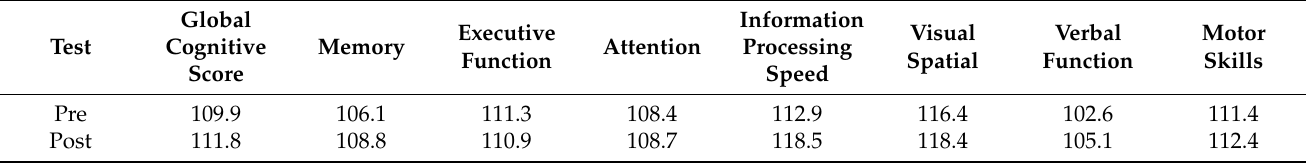
Figure 2. Pre-test and post-test values for jump height and grip strength. Data are means (SD). * indicates significantly improvements from pre-test, p < 0.001. Table 2. Cognitive test results. Raw outcome data are normalized according to age- and education-specific normative data. Then, normalized scores are adjusted to a standard scale with a mean of 100 (standard deviation (SD) = 15). On this scale, 100 represents average performance, a score of 85 is 1SD below average, and a score of 115 is 1SD above average. A Global Cognitive Score is the average of all index scores and serves as a measure of overall battery performance (NeuroTrax data report guide)